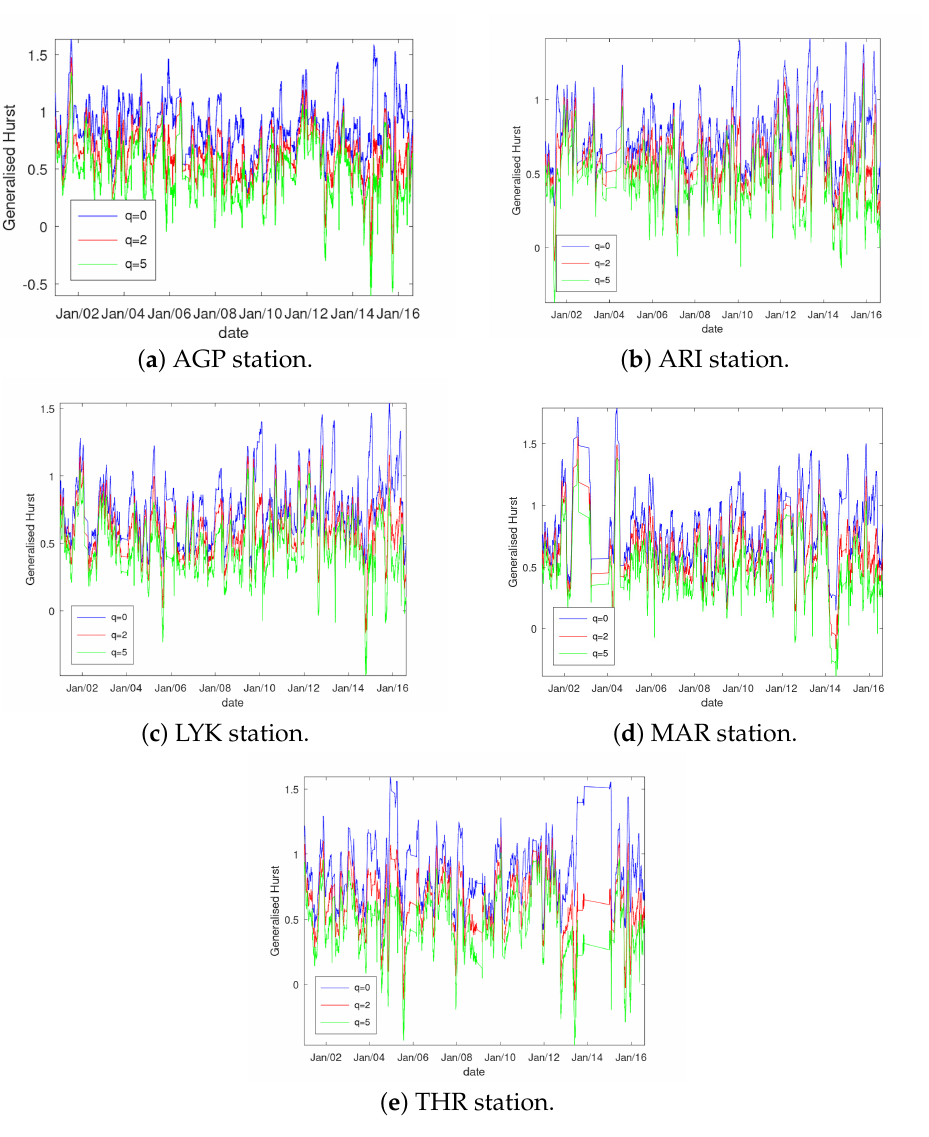
Figure 13. Results of the sliding window